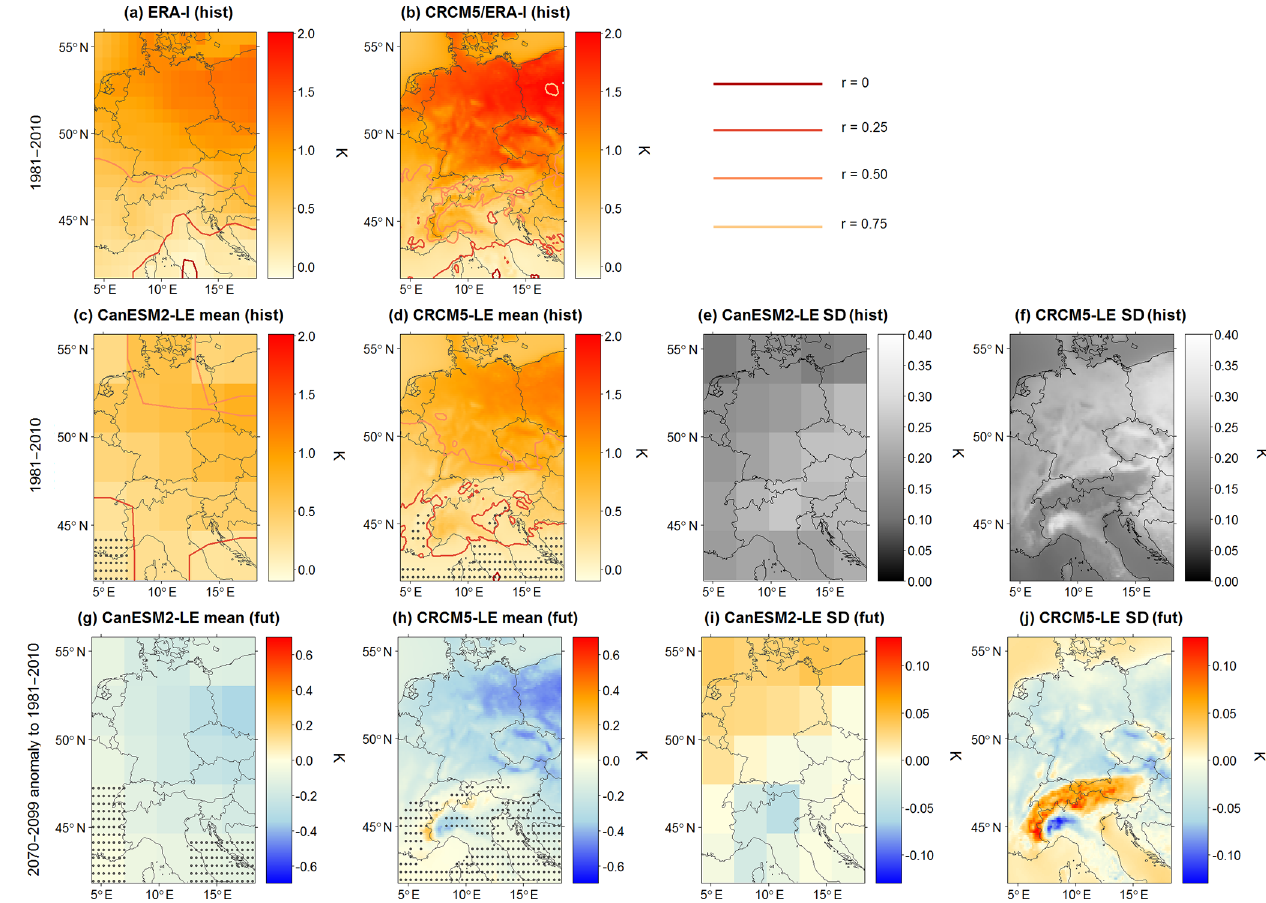
Figure 6. Spatial patterns of change in nSAT mean ( α 1 in K) for a unit change in the NAO index for ERA-I, CRCM5/ERA-I, CanESM2- LE and CRCM5-LE in 1981–2010 (a–f) and the change in 2070–2099 with respect to 1981–2010 (g–j) . Both 50-member ensembles are represented with ensemble mean (c–d, g–h) and standard deviation (SD, e–f , i–j ) representing the inter-member spread. Reddish lines in the ensemble mean maps represent the Pearson correlation between nSAT mean and the NAO index at an increment of 0.25; red shadings – see legend in upper right panel. Grey stippling in the ensemble mean maps indicates regions where SNR < 1, with SNR being the signal-to-noise ratio between the 30-year ensemble mean and SD of GCM- and RCM-LEs in both time periods. Stippling will be explained in more detail in Sect.